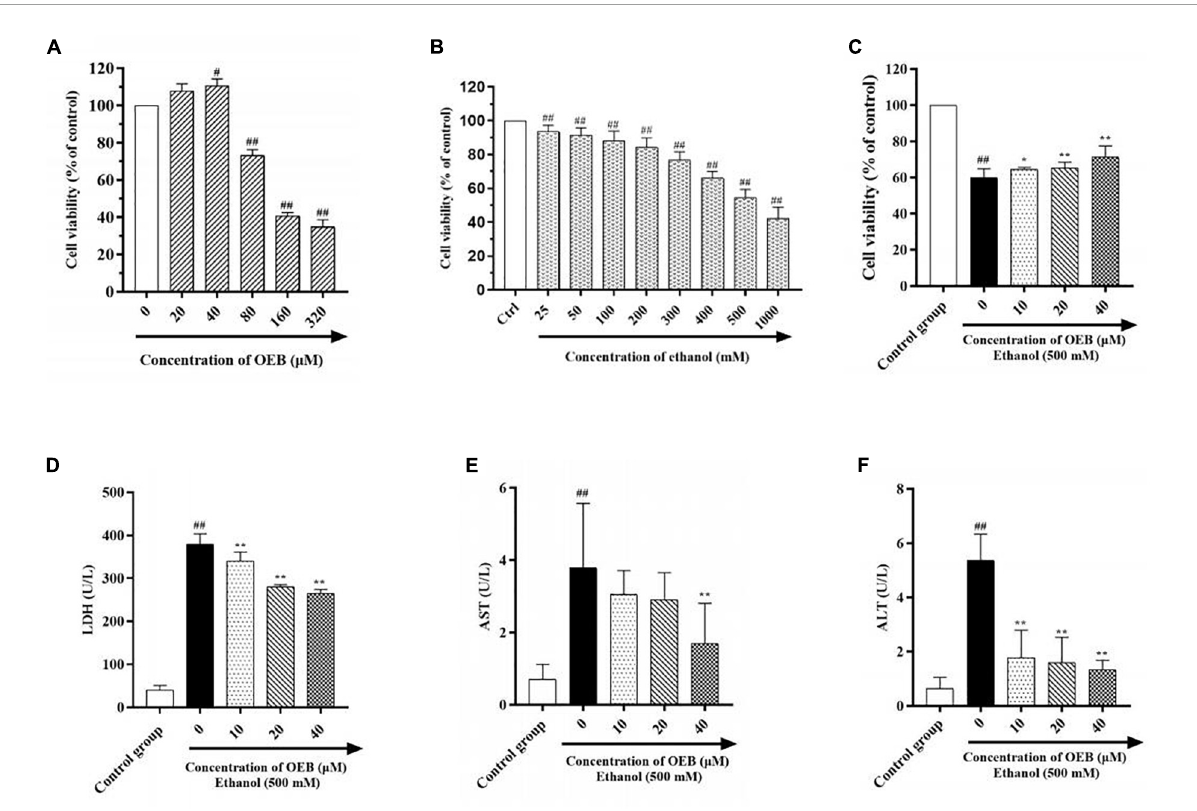
FIGURE1 OEB alleviated ethanol induced cytotoxicity in HepG2 cells. (A) Cells were treated with OEB (0–320 µ M) for 24 h. (B) Cells were treated with ethanol (0–1,000 mM) for 24 h. (C) Cells were pretreated with OEB (10–40 µ M) for 6 h, followed by ethanol (500 mM) for 24 h. The levels of LDH (D) , AST (E) , and ALT (F) released by cells were detected from the culture supernatant. Data represents mean ± SD ( n = 5). # P < 0.05 and ## P < 0.01 with respect to the control group; * P < 0.05 and ** P < 0.01 with respect to the model